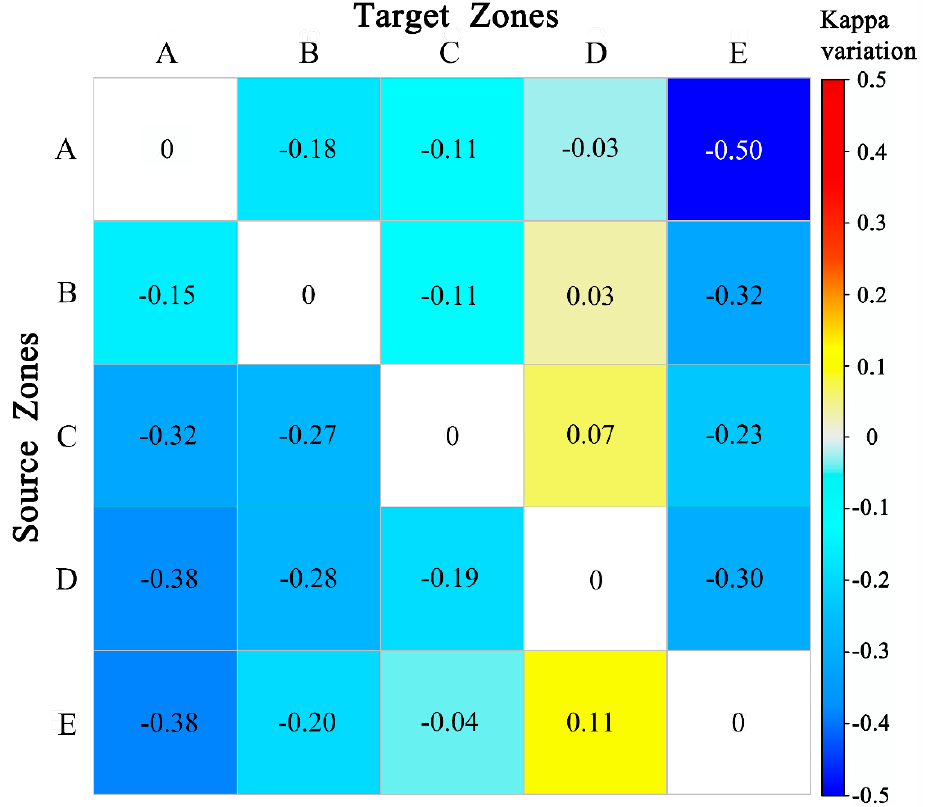
Figure 9. Adaptability of individual samples and models. The value in each grid represents the variation of the UV-detection kappa coefficient in the target zone when the sample and model of the source zone are applied, compared with the original model of the target zone.